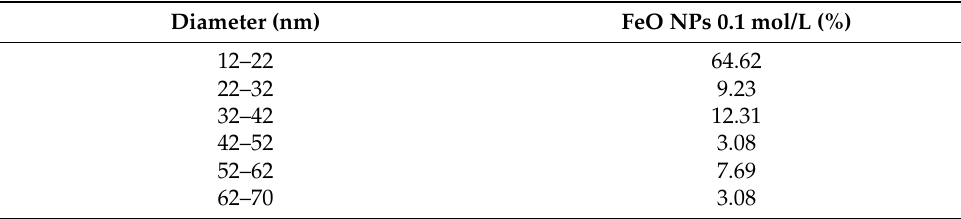
Table 4. Percentage presence of 0.1 mol/L FeO NPs, in relation to